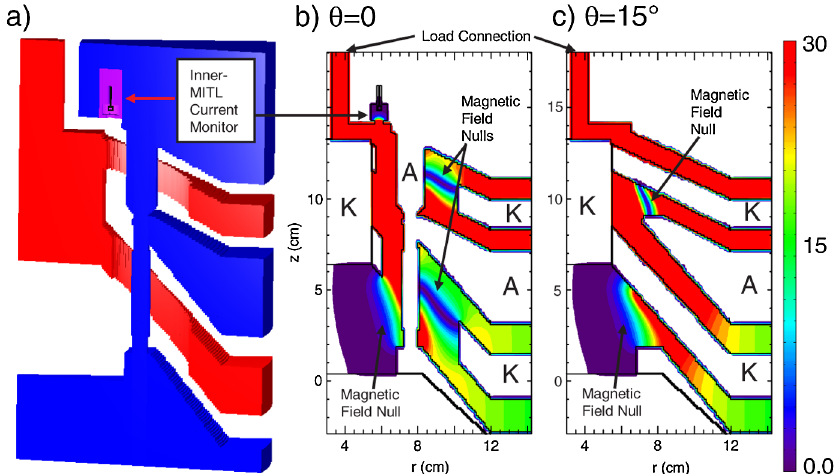
FIG. 2. (Color) ZR convolute simulation geometry used for evaluating inner-MITL current probe designs. (a) 3D rendering of the entire simulation space with cathode parts in blue, anode parts in red. Magnetic field amplitude contours (in kG) at t ¼ 45 ns in the (b) (cid:1) ¼ 0 and (c) (cid:1) ¼ 15 deg simulation planes. Anode (A) and cathode (K) parts are labeled as well as the locations of the magnetic field